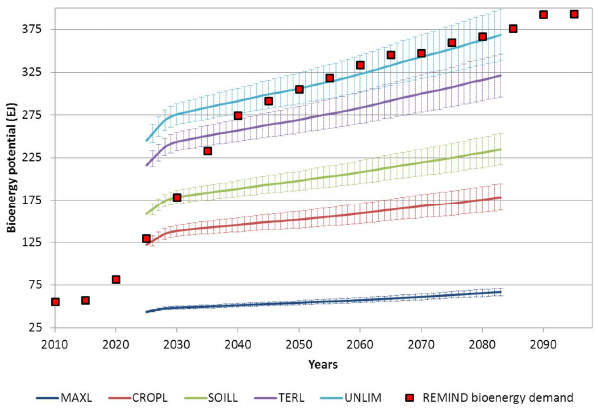
Fig. 9. Total biophysical bioenergy potentials of the area north of 45 ◦ N for the respective land management scenarios. To put the po- tentials into perspective, we have plotted the bioenergy demand (red dots) as simulated by REMIND-R for the “Biomass-max” scenario (Leimbach et al., 2010b). The values plotted are a 30yr moving av- erage. The thick line represents the mean of 19 values while the uncertainty (1 standard deviation) is shown by the error bars. Since perennial bioenergy grasses need a few years to reach full produc- tivity in LPJmL, the total bioenergy potential is lower in the first